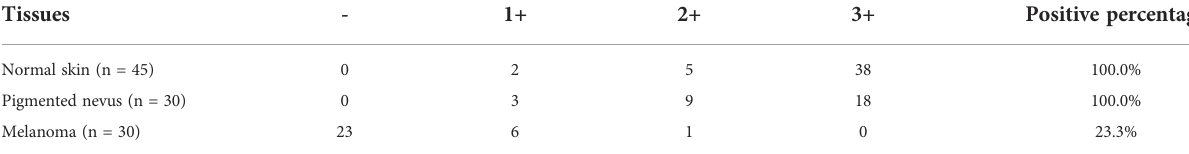
TABLE 2 The positive percentage of PCDH9 expression in normal skin, pigmented nevus, and melanoma tissues.